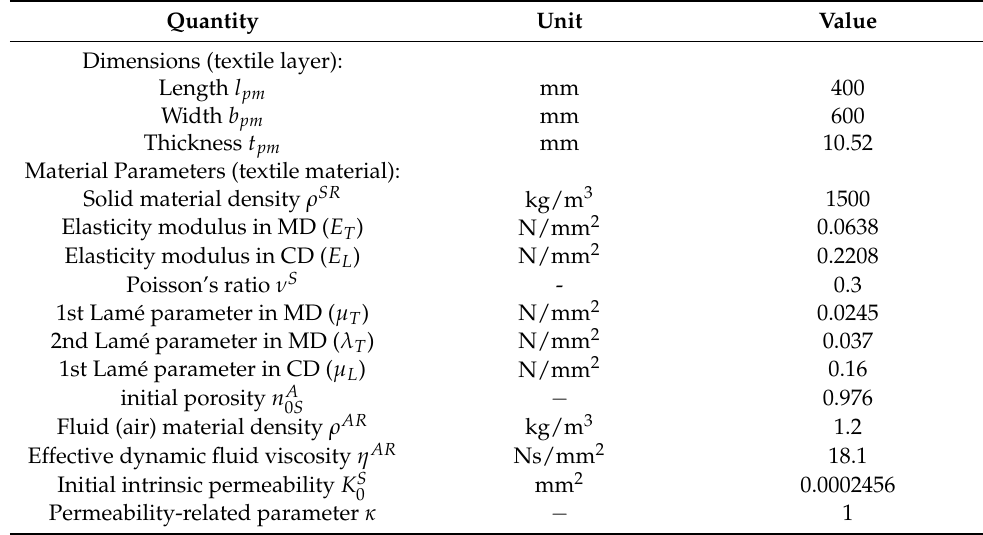
Figure 7. Geometry and boundary conditions of the porous media dynamics model, consisting of a lower plate and an upper textile layer. At the upper boundary, p = 0 (drained), whereas an excitation force F t is applied at the lower boundary of the plate at its center. The side boundaries are fixed in all directions, drained, and the preferred direction of anisotropy is a : = e 2 . Table 4. Parameters for the multiphase textile material, which rely on sample1 in Table 1.